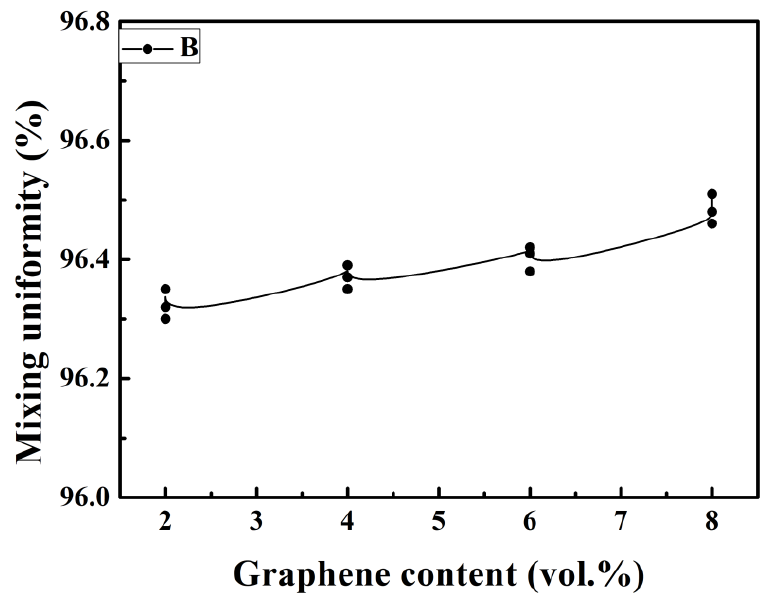
Figure 2. Relationship between graphene content and the mixing uniformity of powders.